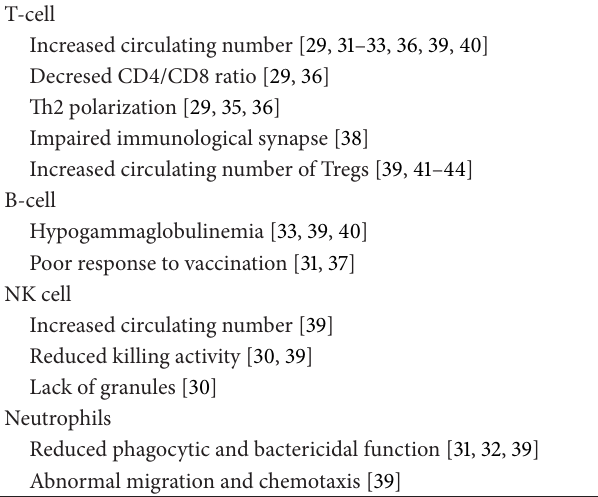
Table 3: Immune defects in